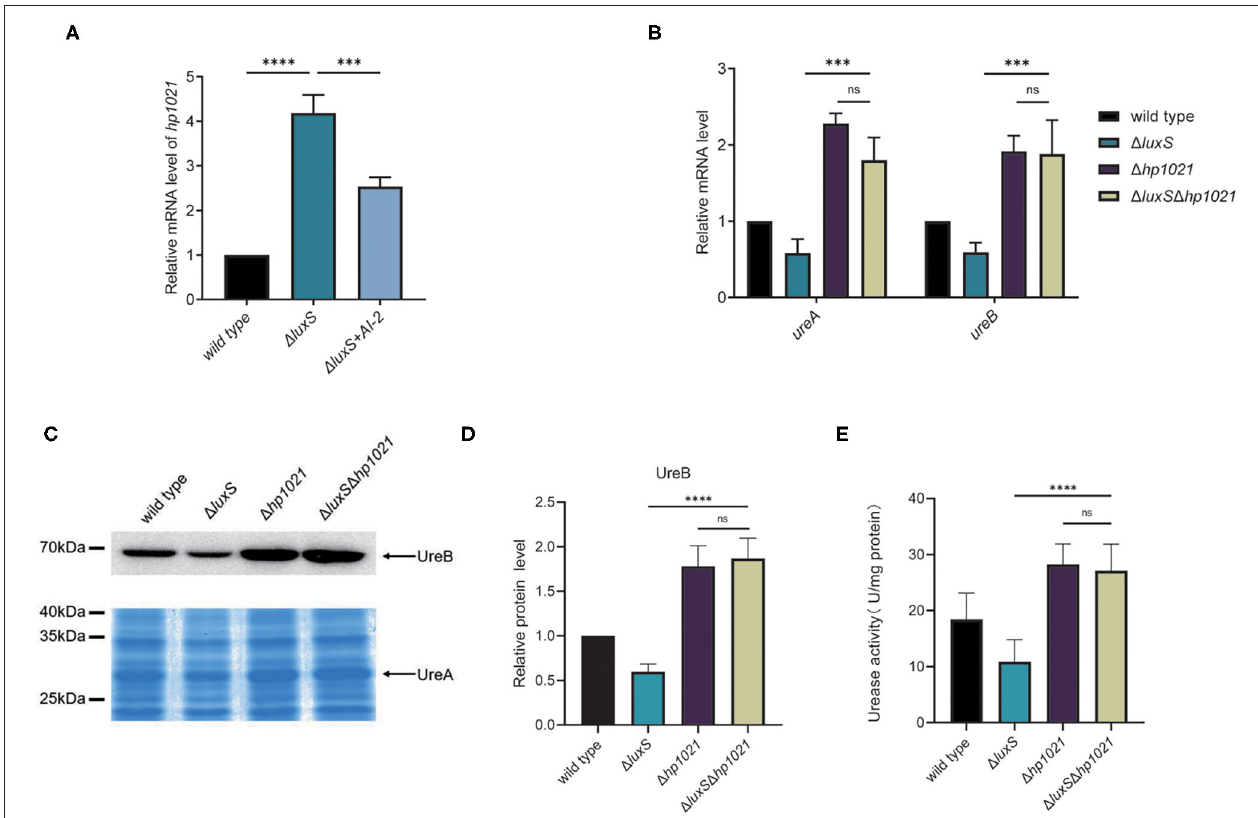
FIGURE 4 | LuxS induced the expression of urease through HP1021. (A) mRNA expression levels of HP1021 regulated by LuxS and supplemented with AI-2, measured by qPCR. Relative mRNA levels represent mRNA levels of HP1021 in the mutant strain and mutant strain supplemented with AI-2 normalized to those in the wild type strain. (B) mRNA expression of UreA and UreB regulated by LuxS and HP1021. Relative mRNA levels represent mRNA levels of UreA and UreB in the mutant strains normalized to those in the wild type strain. (C) Expression of UreA and UreB proteins regulated by LuxS and HP1021. UreB expression was detected by western blotting, and protein bands are indicated with the arrow. UreA expression was measured by SDS-PAGE gel followed by staining with Coomassie brilliant blue. The arrow indicates UreA protein bands. (D) Densitometric analysis of UreB protein bands. Total protein bands stained with Coomassie brilliant blue were used as loading control. (E) Determination of urease activity in cell lysates. Values are the averages from three biological independent experiments and bars represent standard deviations. **** P < 0.0001, *** P < 0.001, ns,